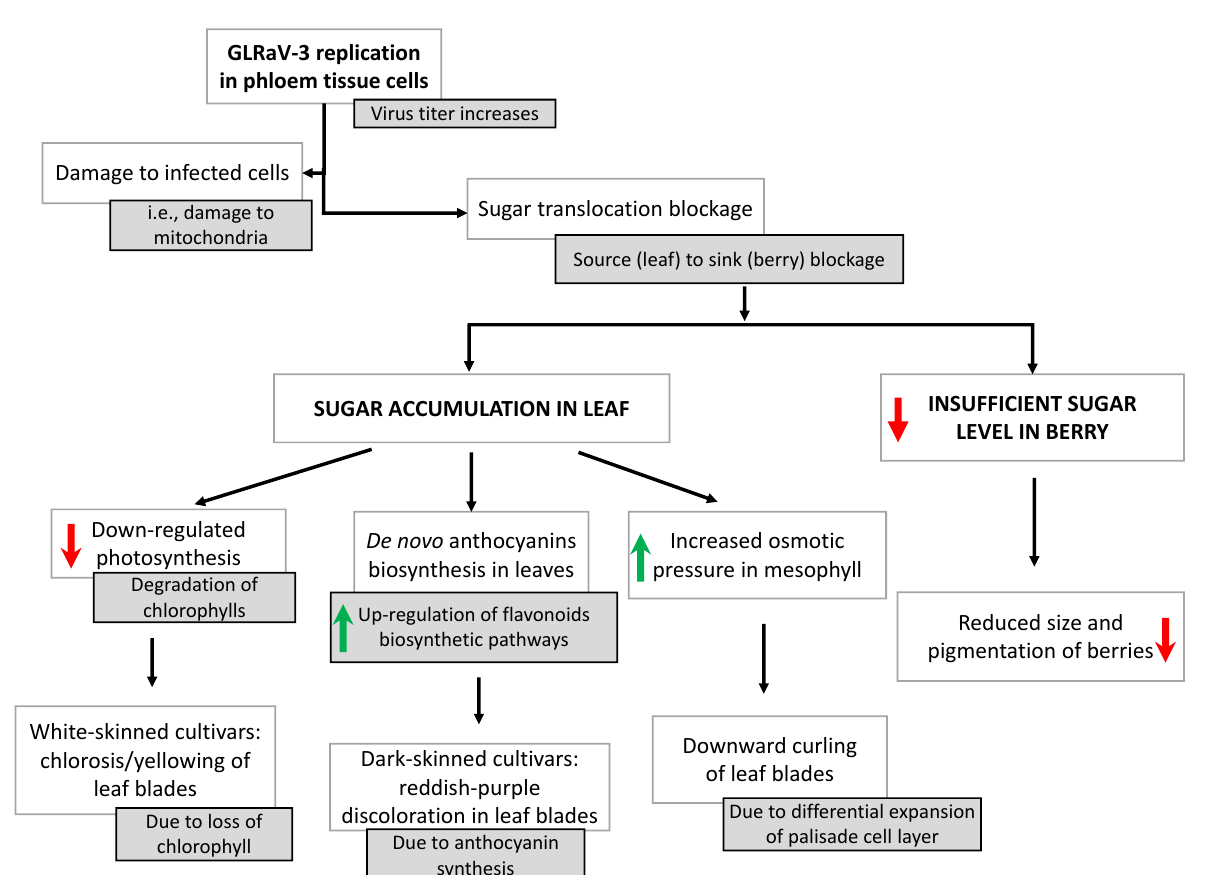
Figure 4. Schematic depiction of our working model on the molecular interactions between GLRaVs and the grapevine host that lead to GLRD and its characteristic symptoms. Red-arrows indicate up-regulation, green arrows indicate down-